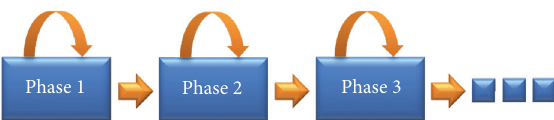
Figure 9: Left to right HMM graphical